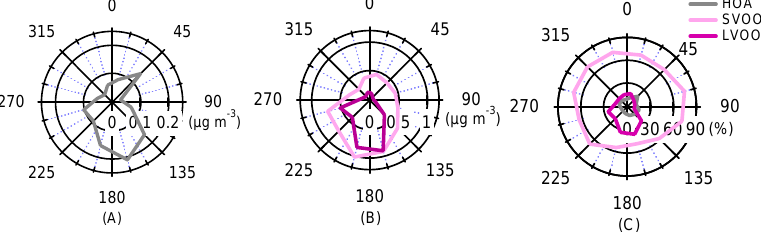
Figure 7. Wind roses for the mass concentrations of (a) HOA, (b) SVOOA and LVOOA, and (c) mass fractions of three species to the total organics.